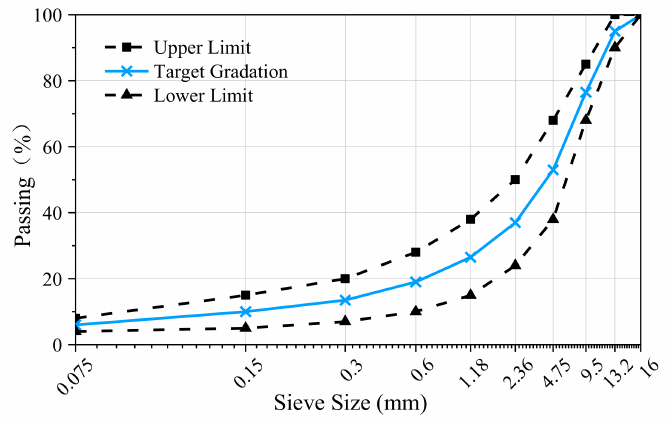
Figure 2. Gradation curve for AC-13.